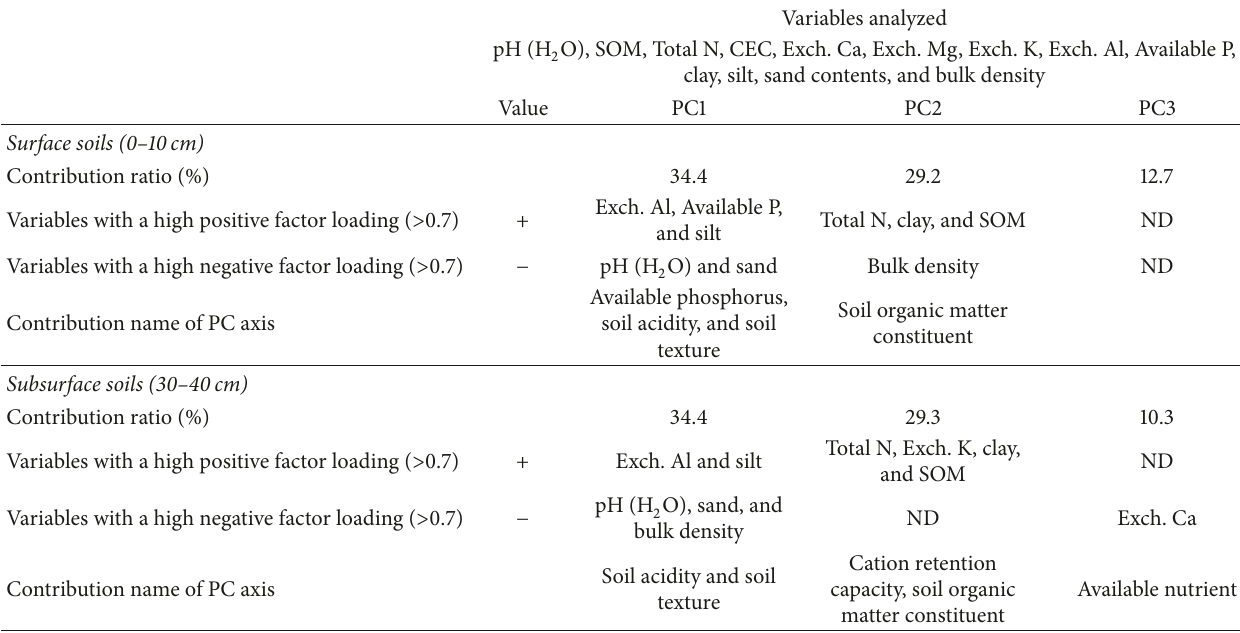
Table 3: Factor loadings of surface and subsurface soil physicochemical properties, principal component analysis (PCA), and results of PCA of the rehabilitated forest.